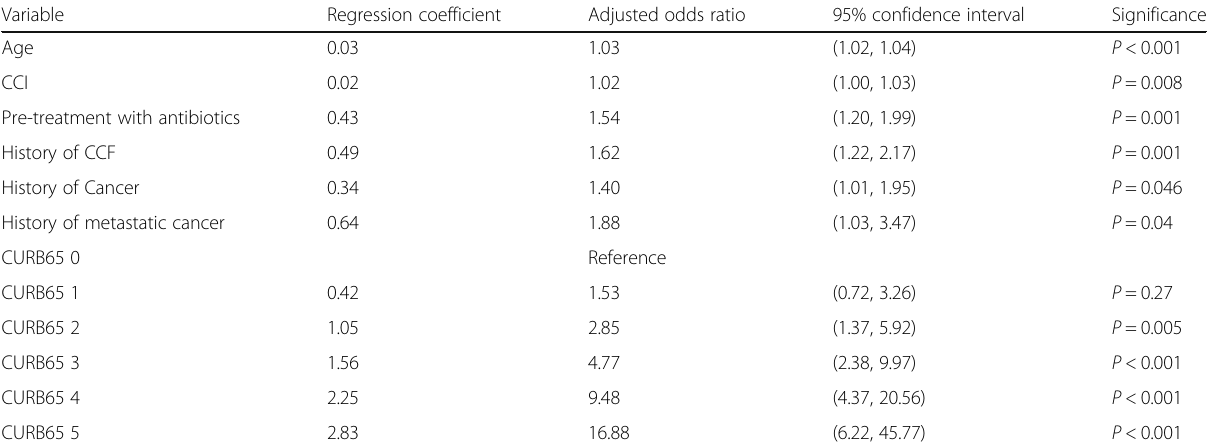
Table 5 Analysis of subjects with a documented CURB-65 score Variable